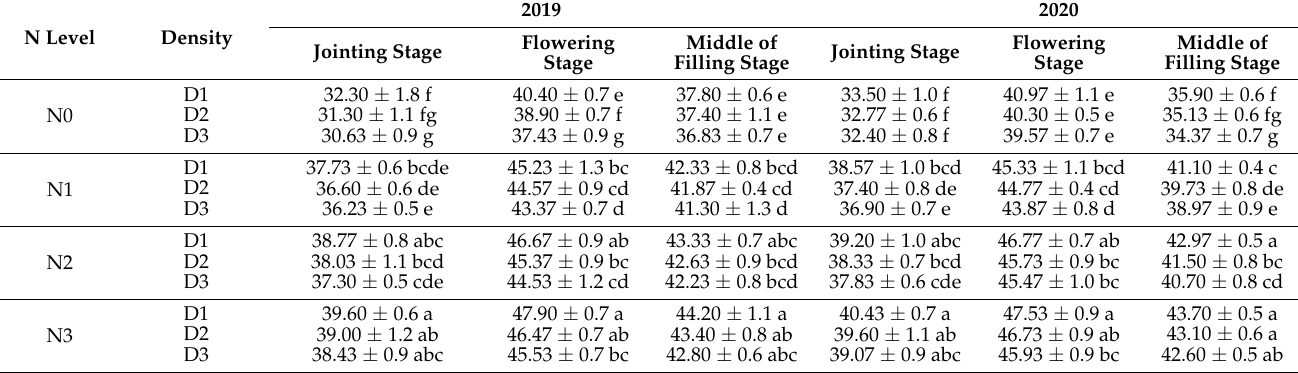
Table 3. The interaction of increasing density and decreasing N on chlorophyll content at different growth stages ( SPAD ). N Level